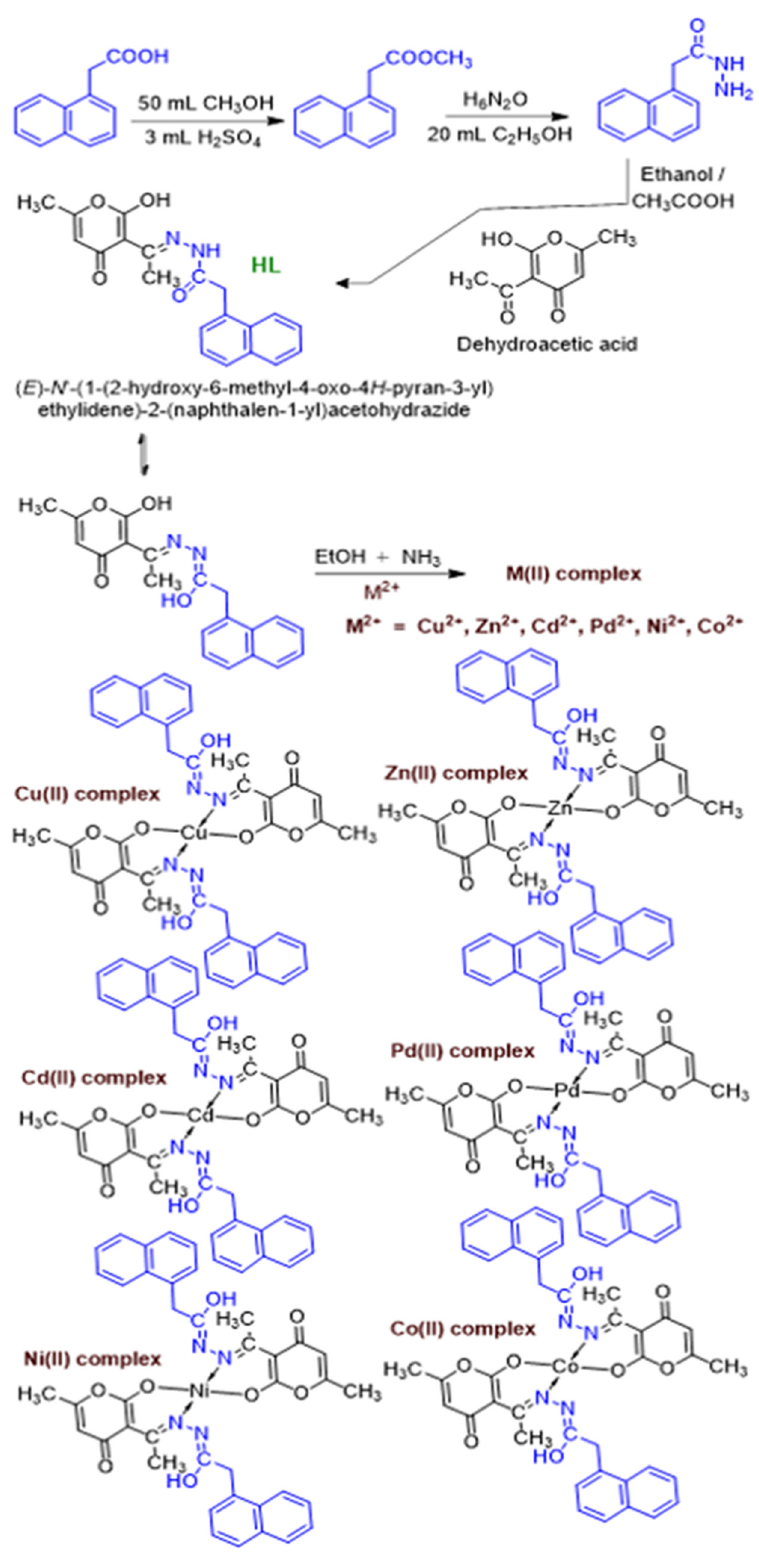
Figure 2. Synthesis of naphthyl hydrazone ligand and their metal (M) derivatives.